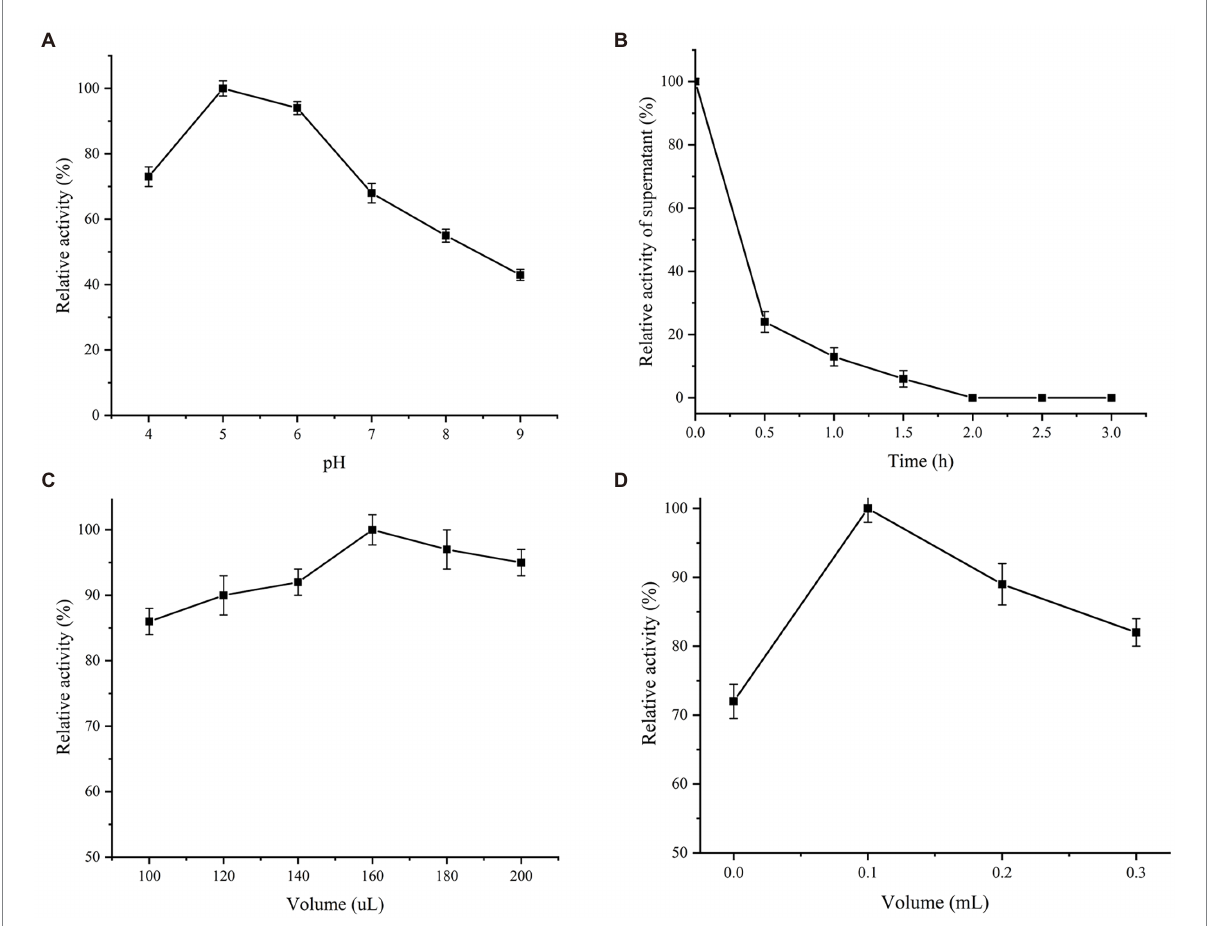
FIGURE 6 Immobilization conditions of Est882. (A) pH. (B) time. (C) enzyme loading. (D) Chitosan addition.